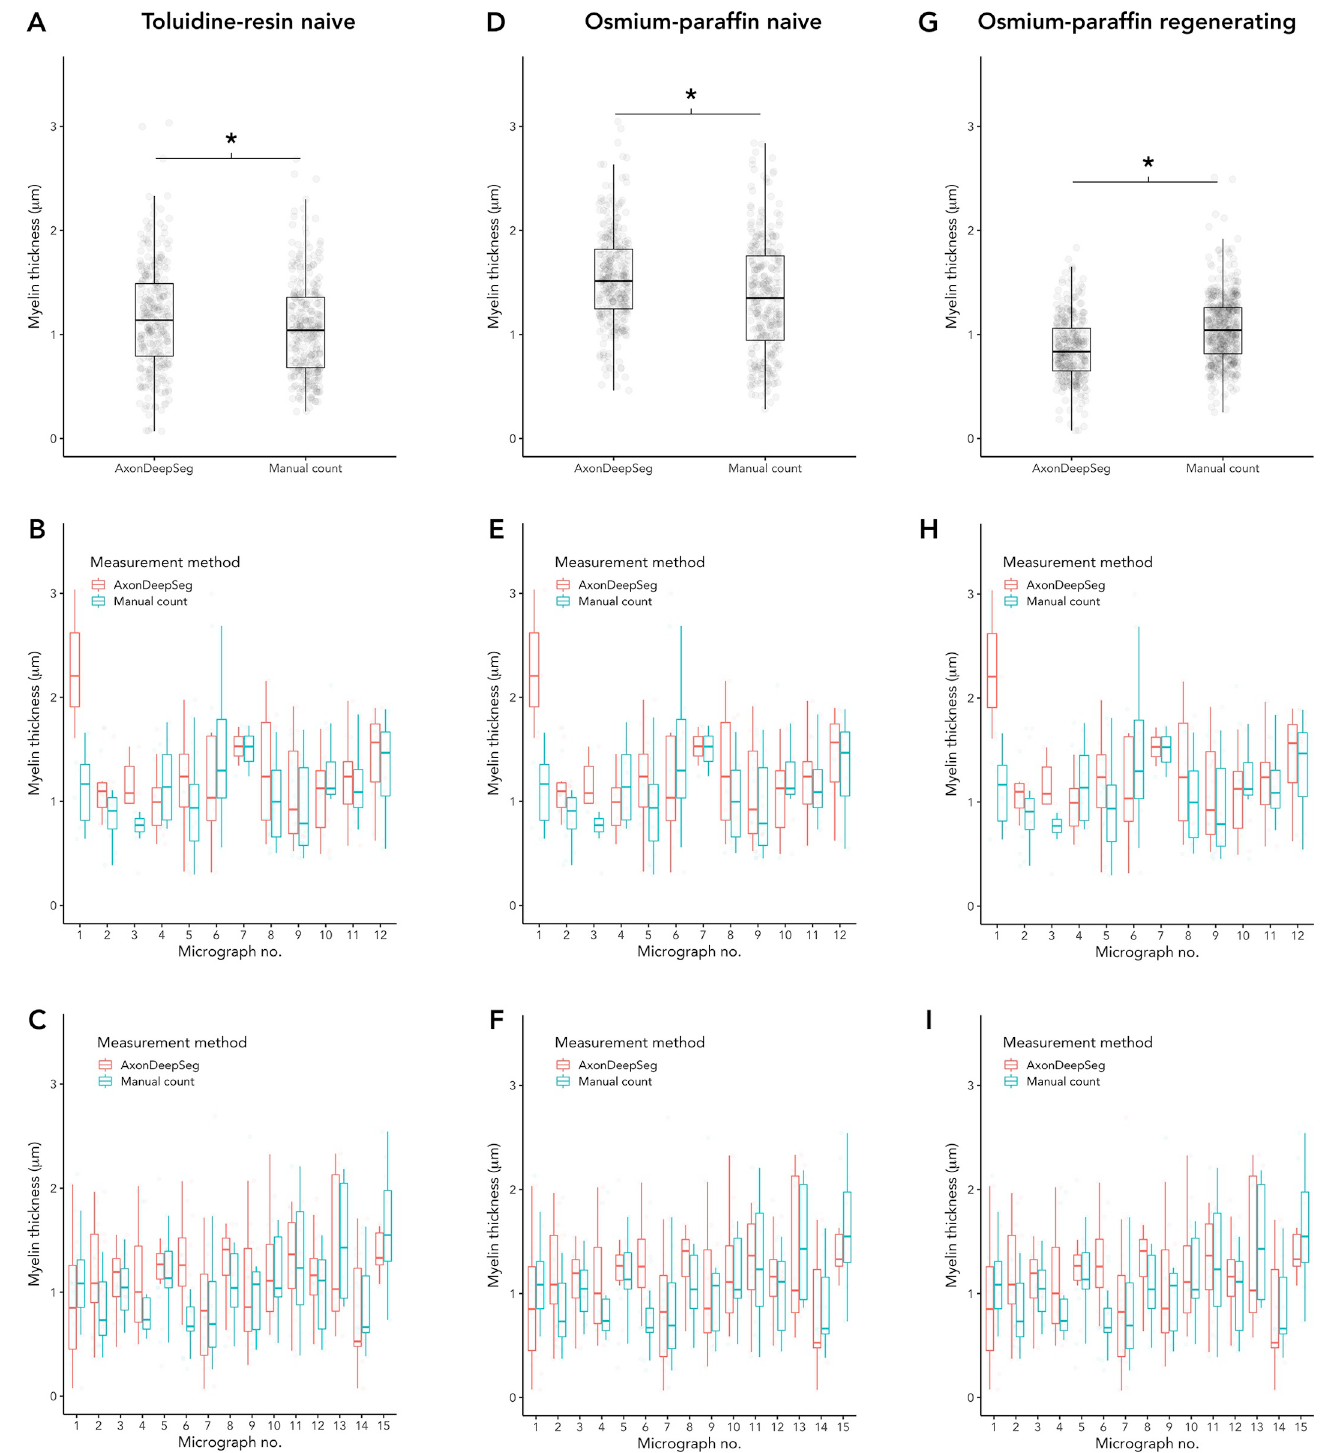
Fig 6. Comparison of myelin thickness measured by ADS or manually. (A-C) Na ï ve nerves, toluidine-resin protocol; (A) Mean myelin thickness for all micrographs for both nerves; (B) Mean myelin thickness in each micrograph for nerve one; (C) Mean myelin thickness in each micrograph for nerve two. (D-F) Na ï ve nerves, osmium-resin protocol; (D) Mean myelin thickness for all micrographs for both nerves; (E) Mean myelin thickness in each micrograph for nerve one; (F) Mean myelin thickness in each micrograph for nerve two. (G-I) Regenerating nerves, osmium-paraffin protocol; (G) Mean myelin thickness for all micrographs for both nerves; (H) Mean myelin thickness in each micrograph for nerve one; (I) Mean myelin thickness in each micrograph for nerve two. Asterisk ( � ) = significant (P < 0.05 by two-sample t-test). Boxes are 1 interquartile range (IQR), whiskers 1.5 � IQR.